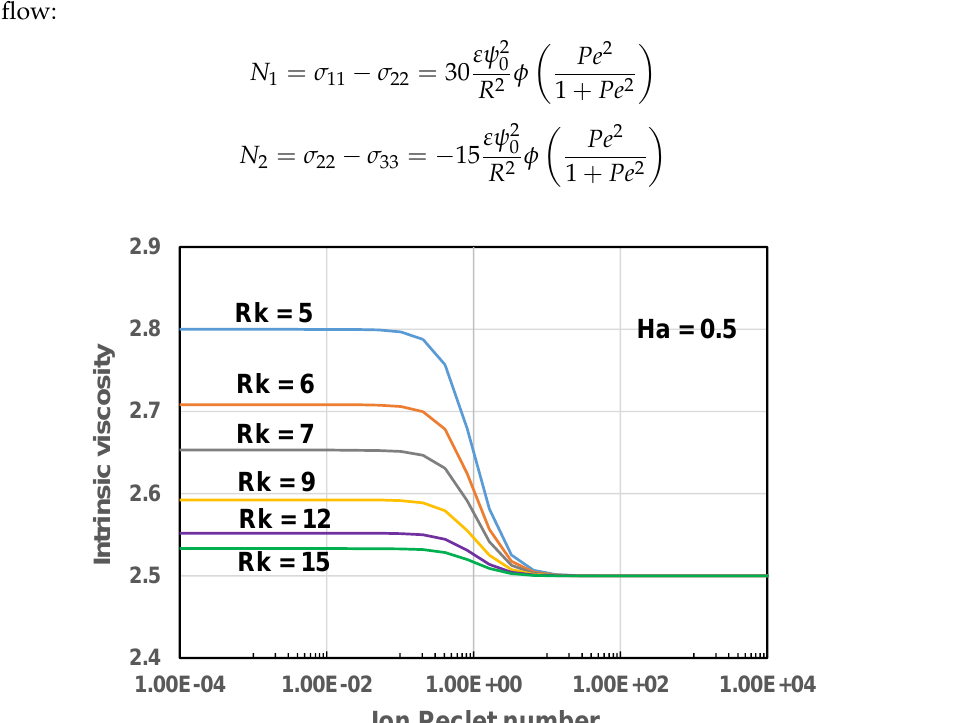
Figure 7. Variation of [ η ] with Pe for suspensions of charged particles at different values of Rk (Ha fixed at 0.5).